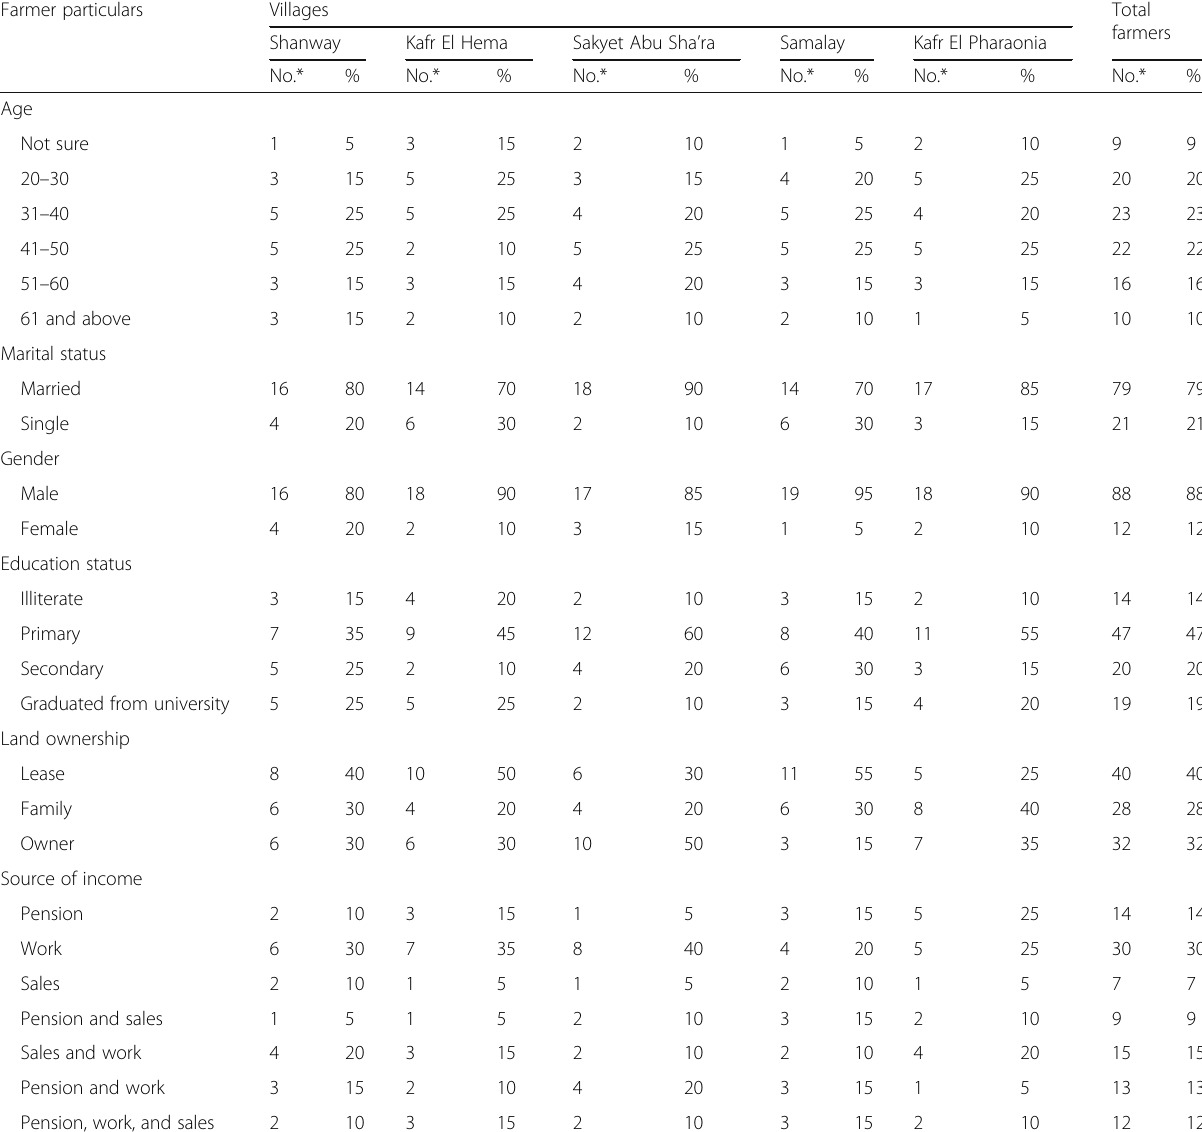
Table 1 Characteristics of sample farmers in rural areas of the Nile Delta in Egypt Farmer particulars Villages Total